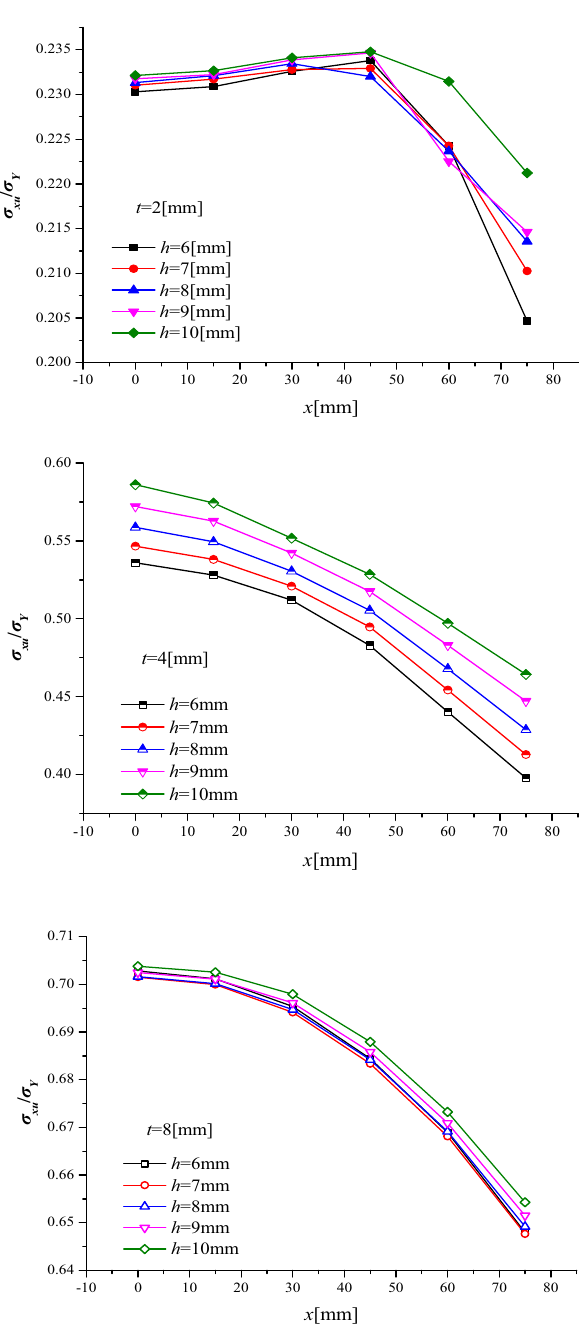
Figure 7: In fl uence of cutout location on ultimate